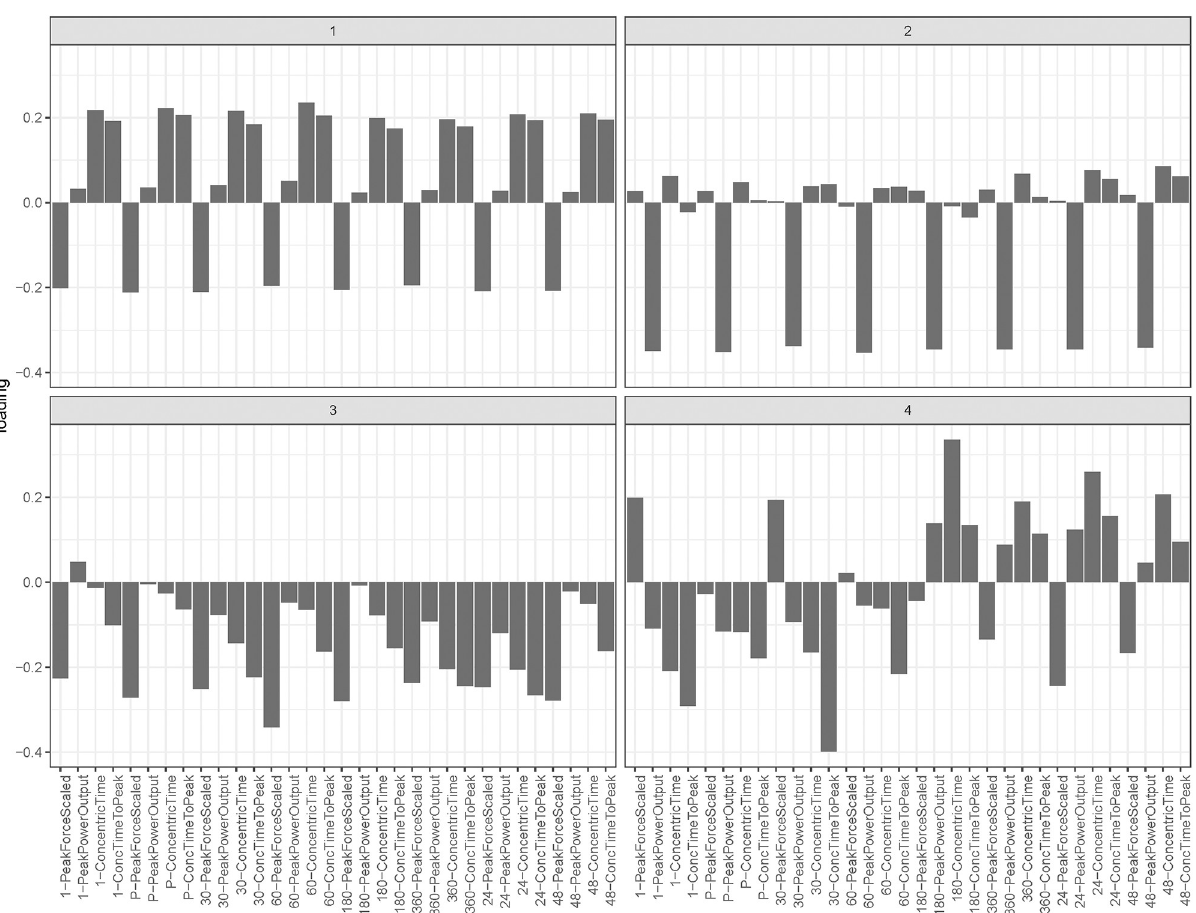
Fig 1. Variable loadings for principal component 1 (PC1) to PC4, showing relative peak force, peak power output, concentric time and concentric time to peak force at each time point. PC1 and PC 2 reflect averaged effects, whereas PC3 shows greater weighting of 6 h to 24 h metrics and PC4 identifies a clear contrast between pre- to 1 h post-training, and 3 h to 48 h post-training effects.